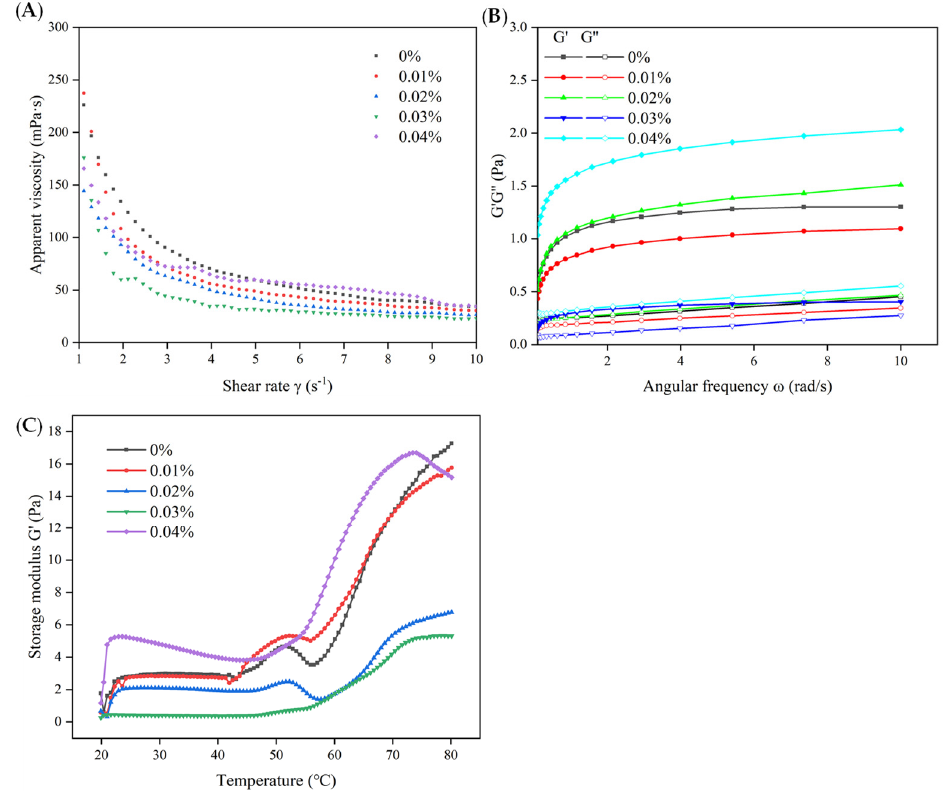
Figure 3. Flow curves (viscosity versus shear rate) ( A ), plots of G ′ and G ″ versus ω ( B ) and changes in G ′ ( C ) of wooden breast myofibrillar protein emulsion heated from 20 to 80 ℃ with different (-)-epigallocatechin-3-gallate additions.